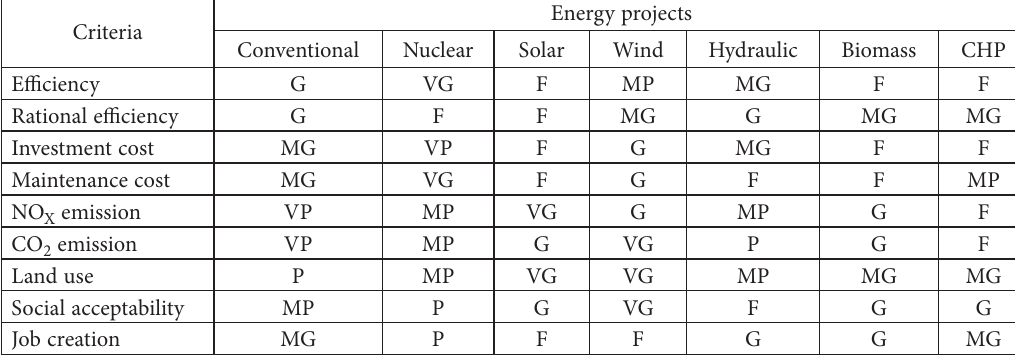
Table 2. Judgment matrix of